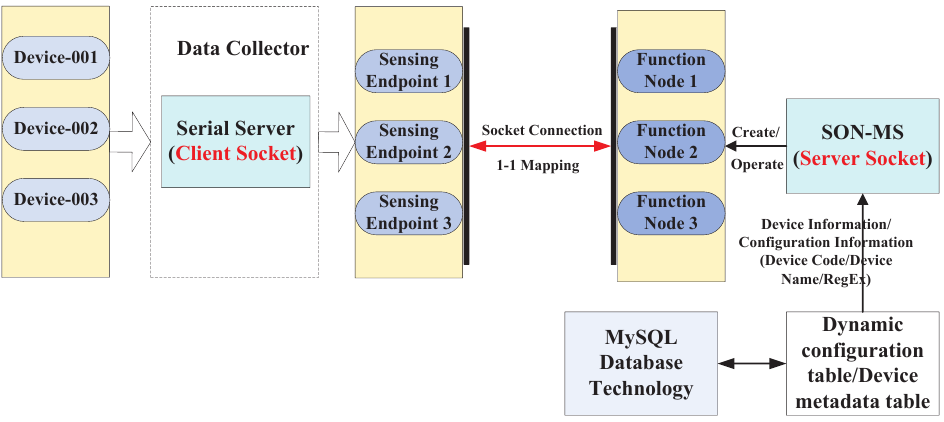
Figure 5. The mechanism diagram of an underwater device, data collector and